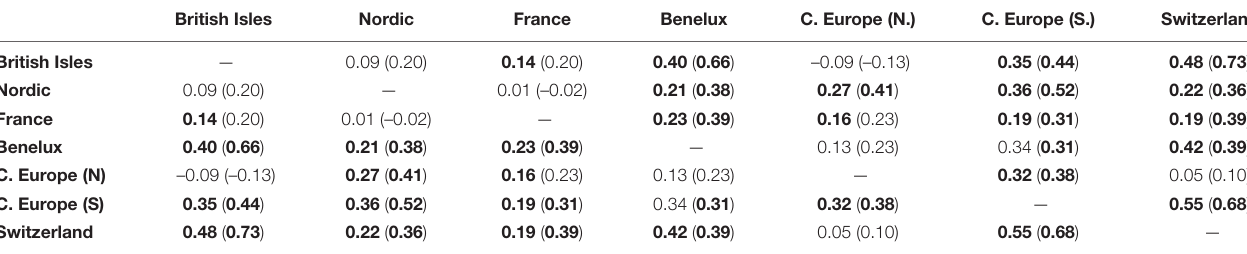
TABLE 2 | Annual correlation between the 300-year filtered and standardized regional subsets of felling dates. British Isles